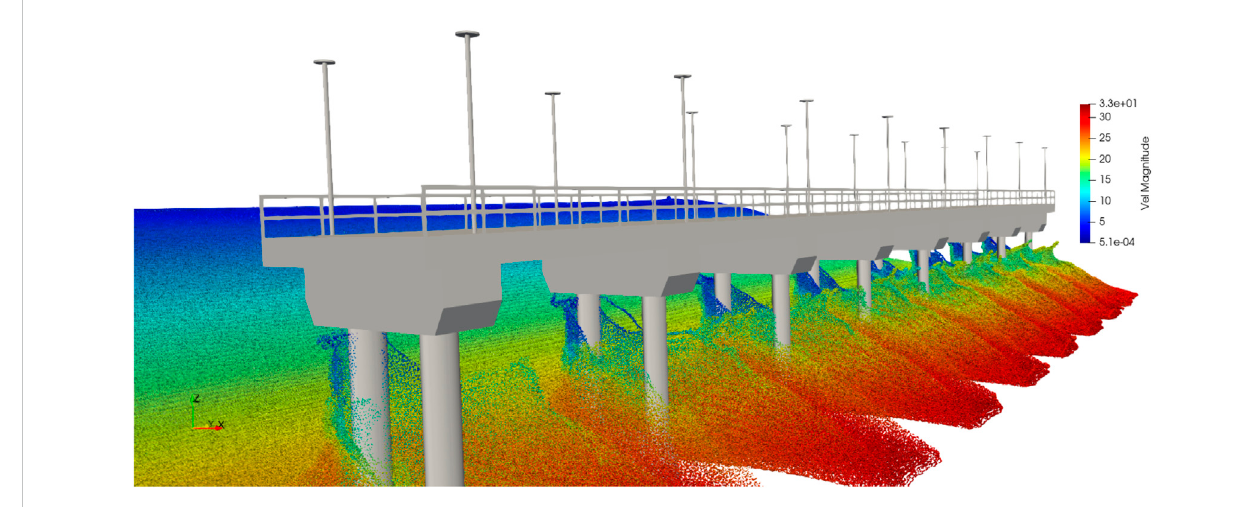
FIGURE 16 Simulation details of water fl ow ( fl uid particle) after passing through the